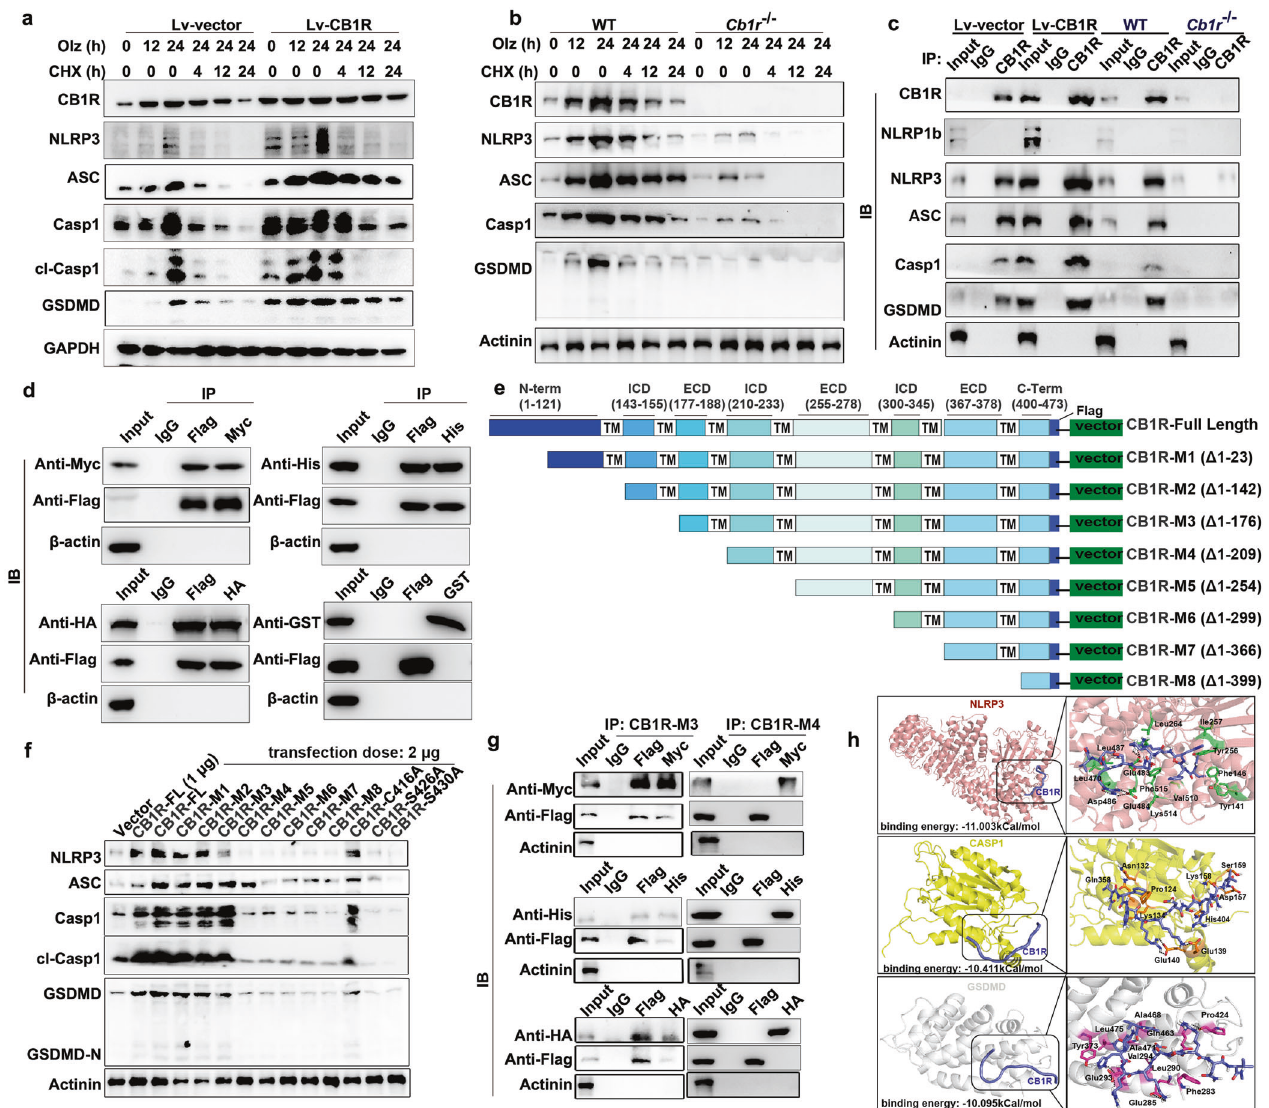
Fig. 4 CB1R assembled multiple pyroptosis proteins via amino acids 177 – 209 and prevented the NLRP3 in fl ammasome from degradation. a , b In the Cb1r knockout HL-1 cells or the Cb1r stably overexpressed HL-1 cells, Olanzapine (Olz, 4 μ M) with or without the speci fi c protein synthesis inhibitor (cyclohexane, CHX, 200 nM) were added to treat cells for indicated hours. Western blot was performed to detect the protein levels of pyroptotic proteins. c In the Cb1r knockout HL-1 cells or the Cb1r stably overexpressed HL-1 cells, co-immunoprecipitation (Co-IP) assay was performed to detect the endogenous physical interaction between CB1R with pyroptotic proteins. d A fl ag-tagged Cb1r plasmid was co-transfected with each of the Myc-tagged Nlrp3 plasmid, His-tagged Gsdmd plasmid, HA-tagged Casp1 plasmid, and the GST-tagged Asc plasmid in HL-1 cells. Co-IP assay was performed to detect exogenous interaction of CB1R with the NLRP3 in fl ammasome. e Schematic illustration of mouse CB1R with full length (CB1R-FL, 1-473 amino acids), and truncated domains including Δ 1-23 (CB1R-Mutant 1, or CB1R- blot assay was performed to detect the protein levels of pyroptotic proteins. g The CB1R-M3 and CB1R-M4 plasmids were individually transfected into HEK293T cells in combination with each of the recombinant pyroptosis plasmids. Co-IP assay was conducted to detect protein interaction. h The simulated interaction diagram of human CB1R peptide (amino acids 177-189) with human proteins NLRP3 (up, pink cartoon), CASP1 (middle, yellow cartoon), or GSDMD (down, gray cartoon) in left panels. Right panels showed the CB1R peptide (blue) and key NLPR3 (green), CASP1 (orange), and GSDMD (purple) residues involved in ligand binding in stick protein levels (Fig. 4f). Moreover, transfection of the CB1R-C416A To further decipher which domain of CB1R was responsible for mutant, which retained the ability to internalize (Fig. 3n), also the regulation of the NLRP3 in fl ammasome, we constructed serial maintained the high abundance of pyroptosis proteins; whereas truncations of the Flag-tagged CB1R plasmid (Fig. 4e). It was found transfection of the CB1R-S426A or CB1R-S430A plasmid, two that the CB1R-FL plasmid promoted the pyroptosis proteins in a mutants that lose internalization capacity (Fig. 3n), failed to regulate the expression of the NLRP3 in fl ammasome (Fig. 4f), reinforcing the requirement of CB1R internalization for regulating the CB1R-FL plasmid effects (Fig. 4f). However, CB1R-M4 and the the NLRP3 in fl ammasome expression. Co-immunoprecipitation following truncation plasmids failed to maintain the pyroptosis